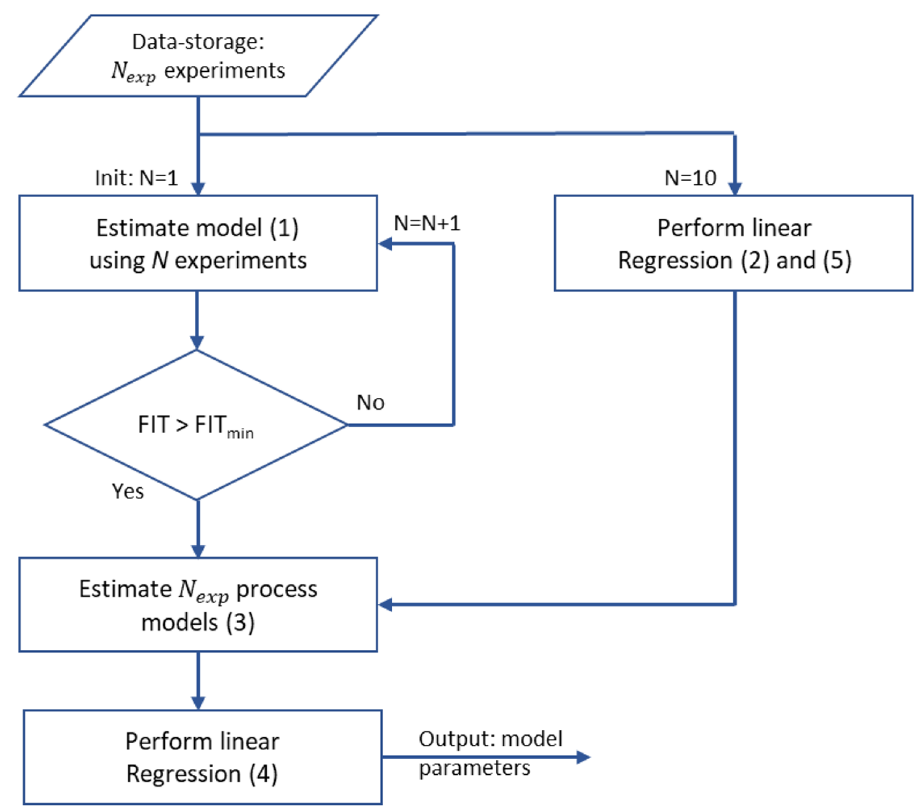
Fig. 4. Flowchart of the model estimation